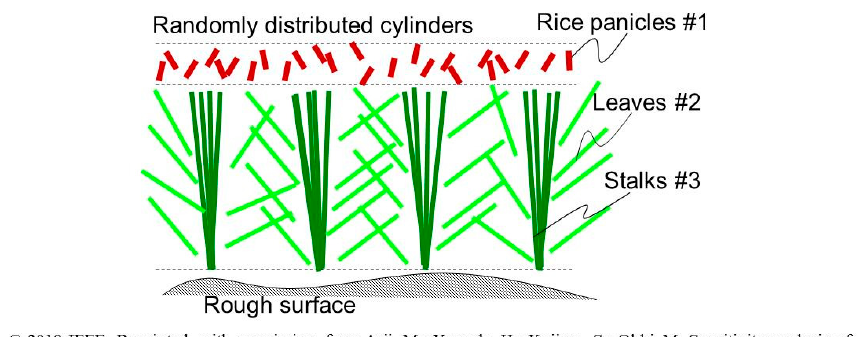
Figure 11. Schematic model for the discrete scatterer model (DSM). Randomly distributed cylinders stand on the dielectric rough surfaces